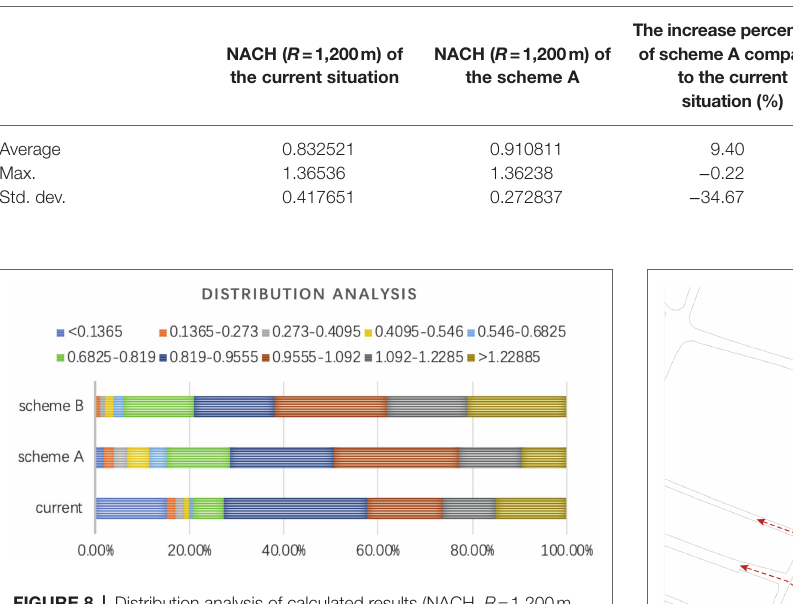
FIGURE 8 | Distribution analysis of calculated results (NACH, R = 1,200 m, segment